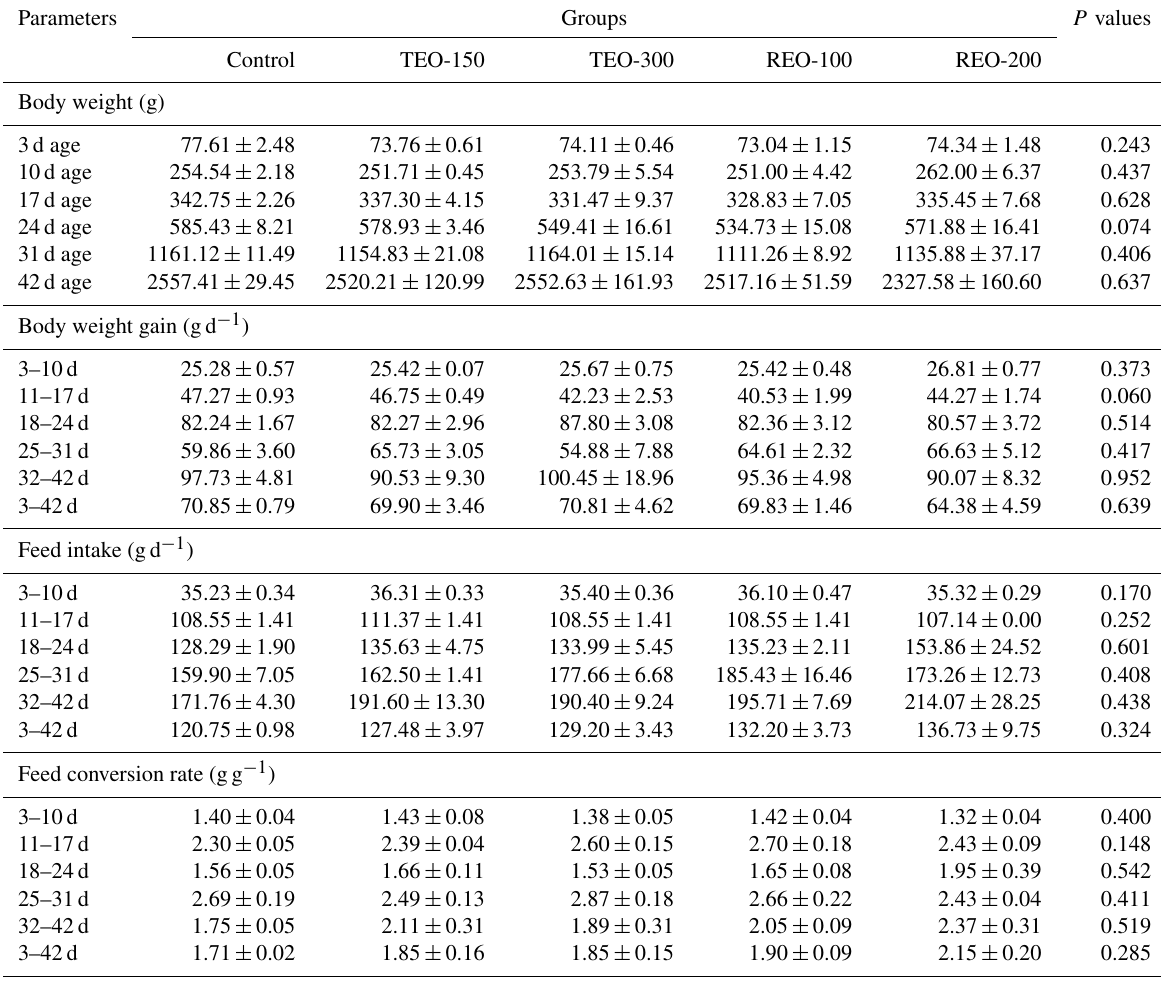
Table 2. Effects of basal ration supplemented with thyme and rosemary essential oils on body weight, body weight gain, feed intake and feed conversion rate in